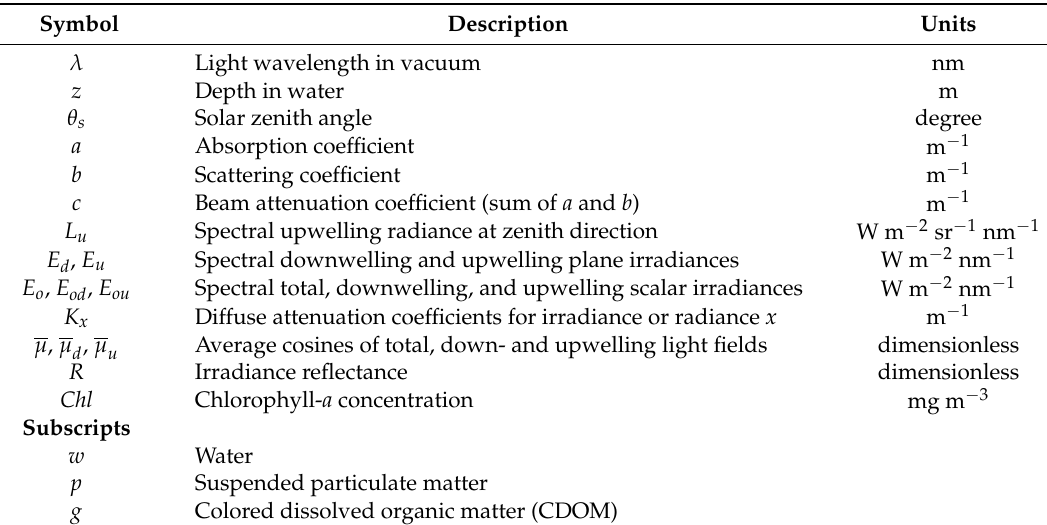
Table 1. Symbols of basic variables used in this